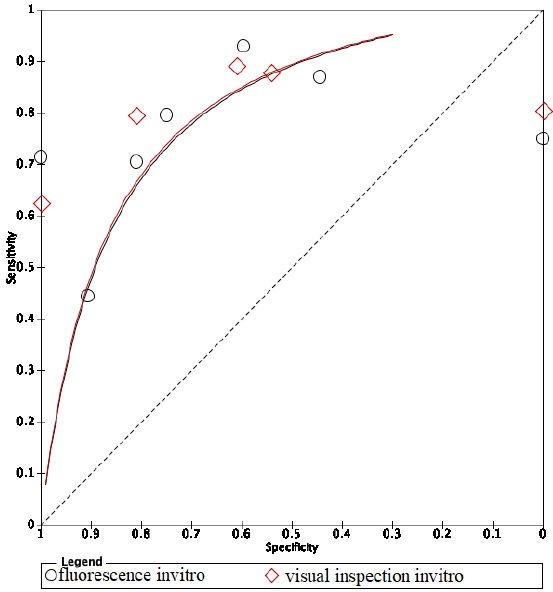
Figure 10. In vitro comparison of fluorescence and visual inspection.